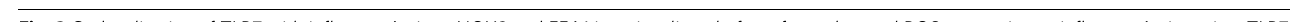
Fig. 2 Co-localization of TLR7 with in fl uenza A virus, NOX2 and EEA1 is a signaling platform for endosomal ROS generation to in fl uenza A virus via a TLR7 and PKC-dependent mechanism. a – c Confocal microscopy of mouse primary alveolar macrophages that were untreated or infected with in fl uenza A virus HKx31 (MOI of 10) and labeled with antibodies to TLR7 and either a in fl uenza A virus NP, b NOX2 or c EEA1, and then with 4 ′ ,6 ′ -diamidino-2-phenylindole (DAPI). Quanti fi cation data from multiple experiments are also shown ( n = 5). d Endosomal ROS production in WT and TLR7 − / − mouse primary alveolar macrophages as assessed by Oxyburst (100 μ M) fl uorescence microscopy in the absence or presence of HKx31 virus and labeled with DAPI ( n = 6). e Immuno fl uorescence microscopy for assessment of NOX2 and p47phox association. WT and TLR7 − / − immortalized bone marrow-derived macrophages (BMDMs) were untreated or infected with HKx31 virus, (MOI of 10) in the absence or presence of ba fi lomycin A (Baf-A; 100 nM) or dynasore (Dyna; 100 μ M), and then labeled with antibodies to NOX2 and p47phox. Also shown is the quanti fi cation of the results ( n = 5). f , g Endosomal ROS production in WT and NOX2 − /y mouse primary alveolar macrophages as assessed by Oxyburst fl uorescence microscopy in the absence or presence of f imiquimod (Imiq; 10 μ g/ml) and g ssRNA (100 μ g/ml) and co-labeled with DAPI. ( n = 5). h , i Cytosolic PKC activity as assessed by FRET analysis in WT and TLR7 − / − BMDMs. Cells were either treated with vehicle controls or with ba fi lomycin A (100 nM) or dynasore (10 μ M) and then exposed for 25 min to in fl uenza A virus (HKx31, MOI of 10) or imiquimod (10 μ g/ml) ( n = 3). a – g Images are representative of > 150 cells analyzed over each experiment. Original magni fi cation ×100. All data are represented as mean ± S.E.M. a , b , c , f and g Student ’ s unpaired t -test * P < 0.05. d , e , h and i One-way ANOVA followed by Dunnett ’ s post hoc test for multiple comparisons. * P < 0.05. Scale bars: 10 µ